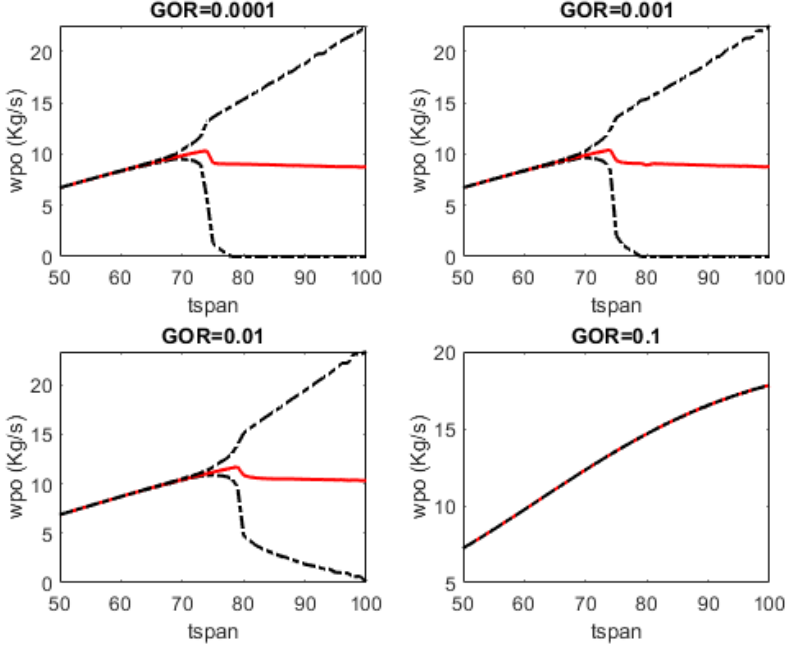
Figure 4. Bifurcation diagrams for GOR = 0.0001, 0.001, 0.01 and 0.1. Mean production (red solid) is reduced after the system goes into instability. A GOR of 0.1 shows no instability for any input